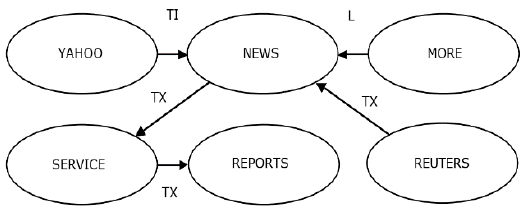
Figure 7. Graph representation of web content